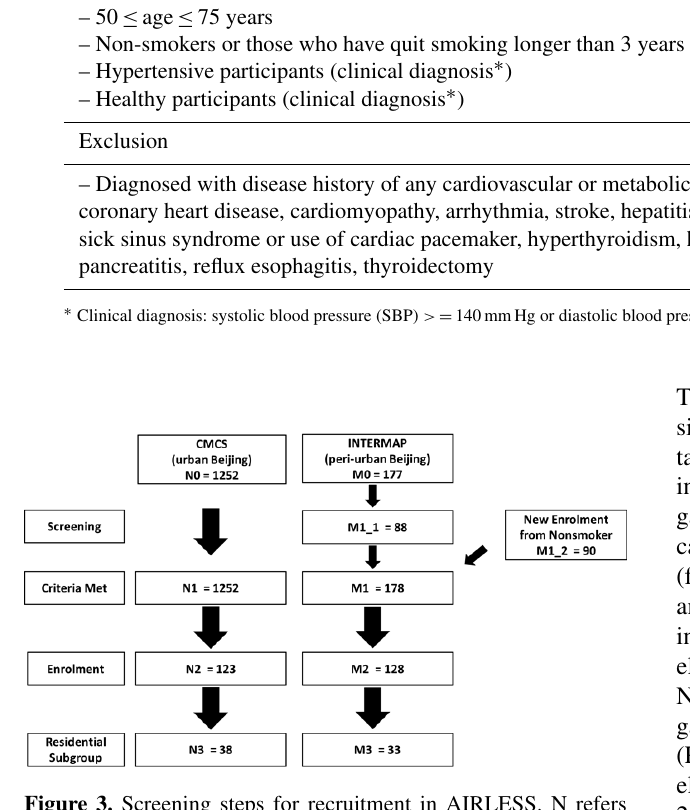
Figure 3. Screening steps for recruitment in AIRLESS. N refers to the sample size of CMCS cohort, and M refers to that of IN- TERMAP cohort; the number after letters N and M refers to the screening